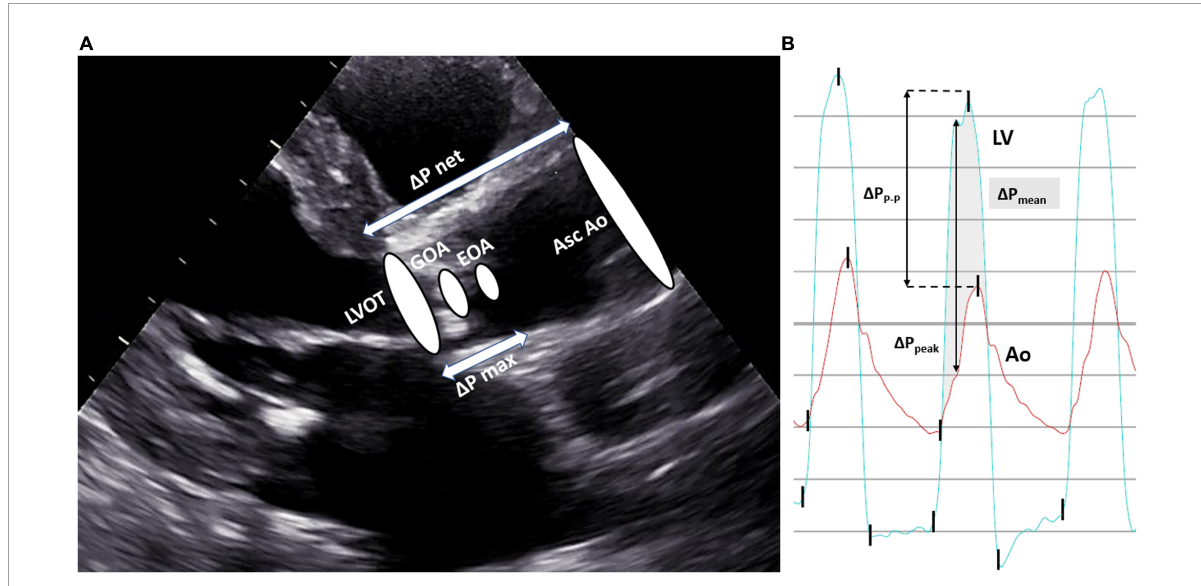
FIGURE1 Echocardiographic and invasive characterization of aortic stenosis. Panel (A) The geometric orifice area (GOA) is the true anatomical area of the aortic valve and the area of the flow jet at the vena contracta, which occurs downstream of the valve orifice, is the effective orifice area (EOA) , and corresponds to the calculated AVA by the continuity equation. GOA is always larger than EOA (they will be equal if GOA has the same size as LVOT). The pressure difference between the LVOT and EOA is known as (cid:49) P max . The pressure difference between the ascending aorta and LVOT is (cid:49) P net , as it is recorded after the occurrence of pressure recovery, and corresponds to the measured pressure drop in the catheterization laboratory. In the presence of the pressure recovery phenomenon, (cid:49) P max is higher than (cid:49) P net , which partially explains the discrepancies between Doppler and invasive metrics. Panel (B) The shaded area represents the mean transaortic pressure drop ( (cid:49) P mean ); peak-to-peak pressure drop ( (cid:49) P P − P ) is the difference between the peak LV pressure and the peak aortic pressure at two different points in time; maximum instantaneous pressure drop ( (cid:49) P peak ) is the maximum recorded difference between the LV and aortic pressure at the same point in time. Ao indicates aortic pressure; Asc Ao, ascending aorta; LV, left ventricle pressure; LVOT, left ventricular outflow tract.